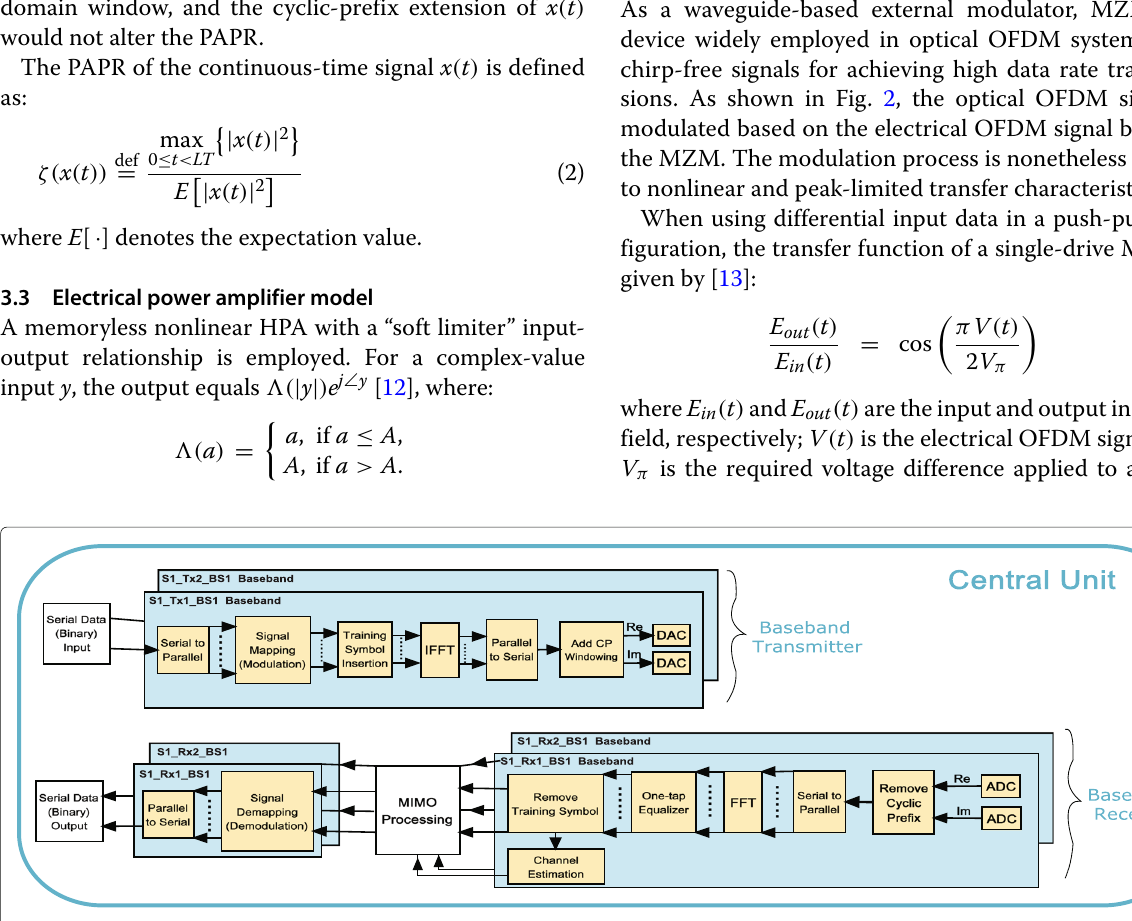
Fig. 3 2 × 2 MIMO-OFDM Baseband Model for RoF Transmission